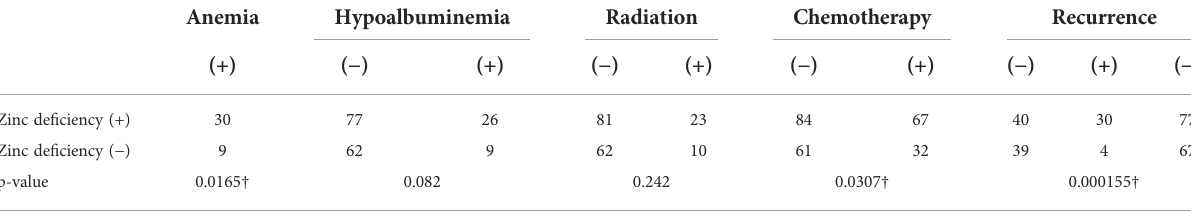
TABLE 4 Fisher ’ s exact test for each factor with and without zinc de fi ciency following cancer